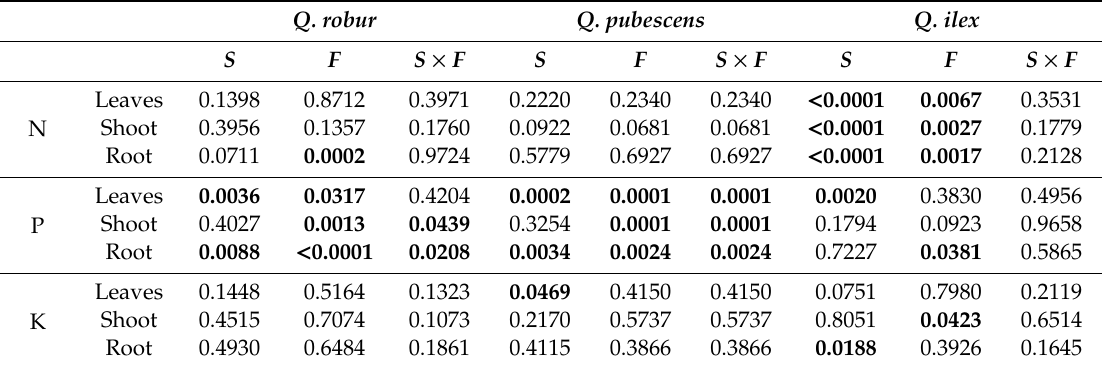
Table 4. p values of multifactorial ANOVA ( p ≤ 0.05 in bold) for macro-element concentration (N, P, K) in leaves, shoot-system, and root-system, at the end of the growing season ( N = 6 couples per stocktype). Source of variation—substrate ( S ), fertilization ( F ), and their interaction ( S × F ). Q. robur